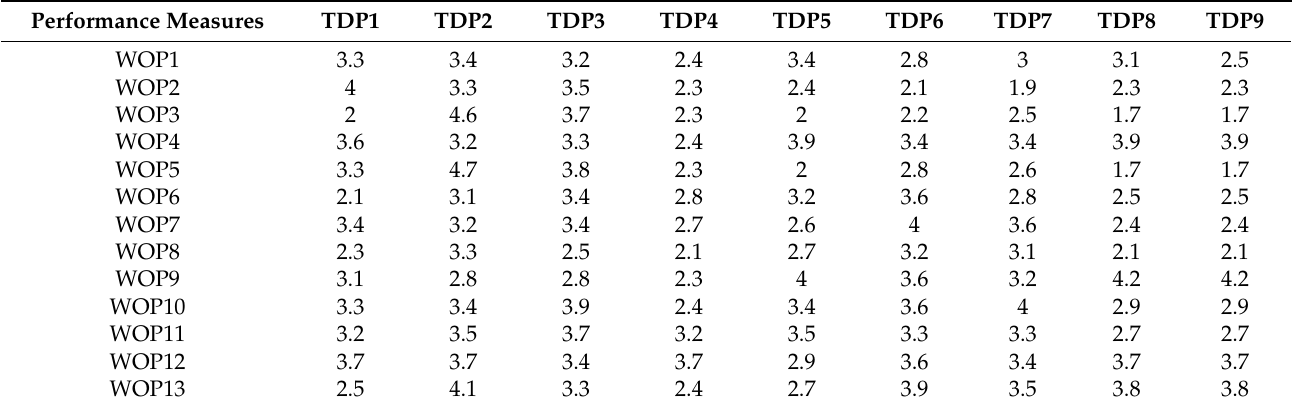
Table 9. Initial decision matrix.